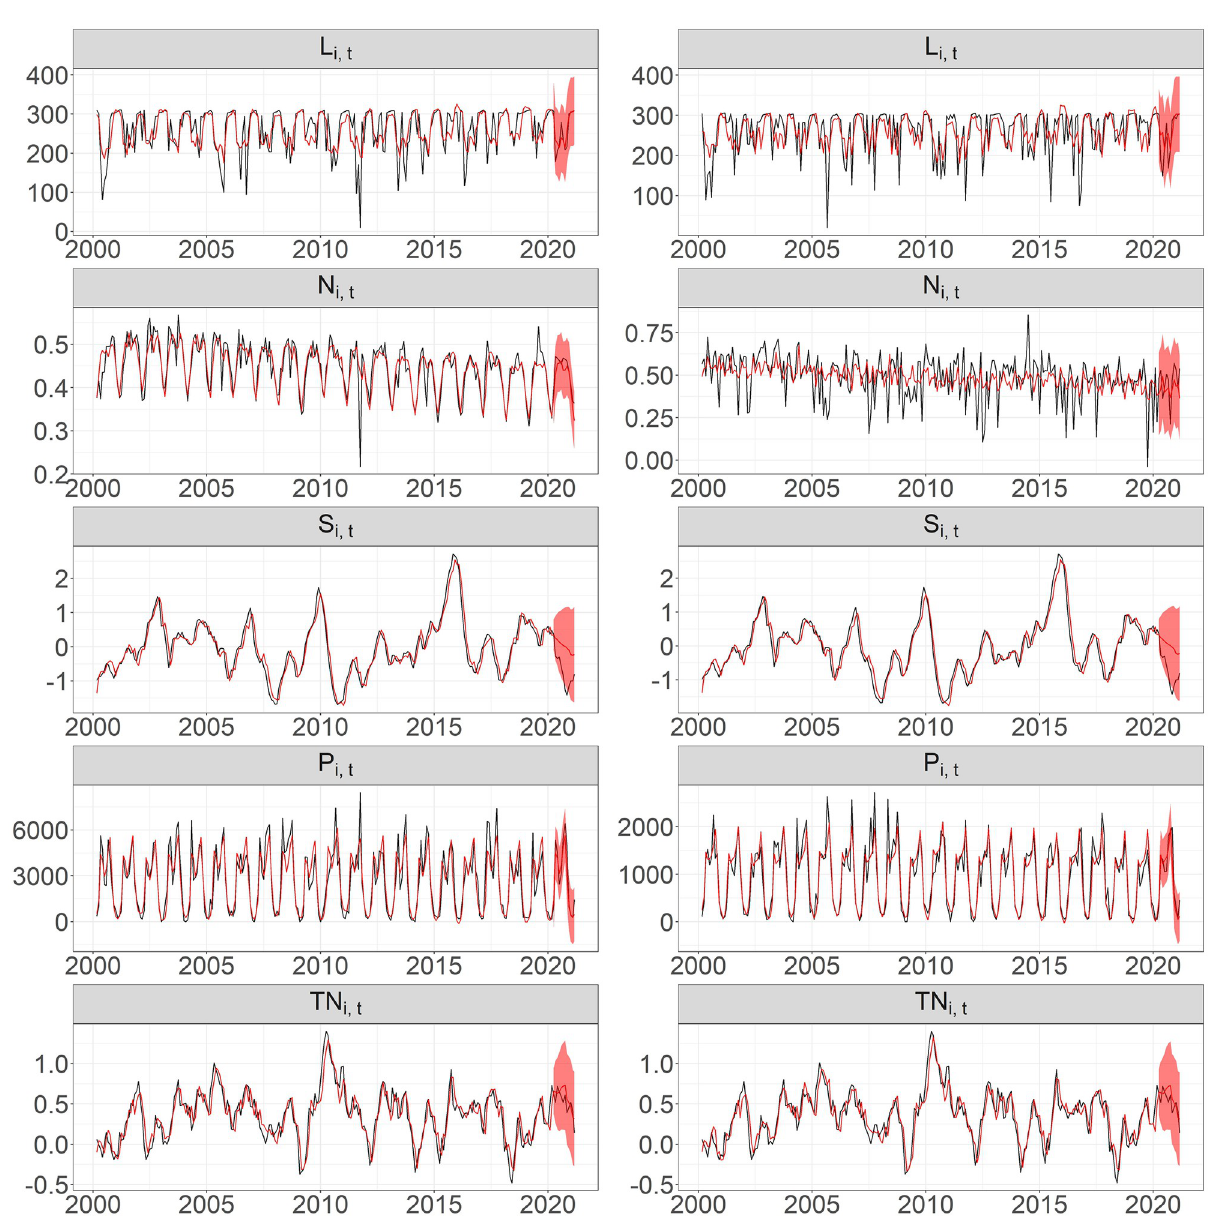
Fig 2. Observed climate covariates and forecast values at two specific cantons: Alajuela (left panels) and Quepos (right panels). Black line: observed climate covariates, red line: forecast values, and red shaded areas: 95% confidence regions.